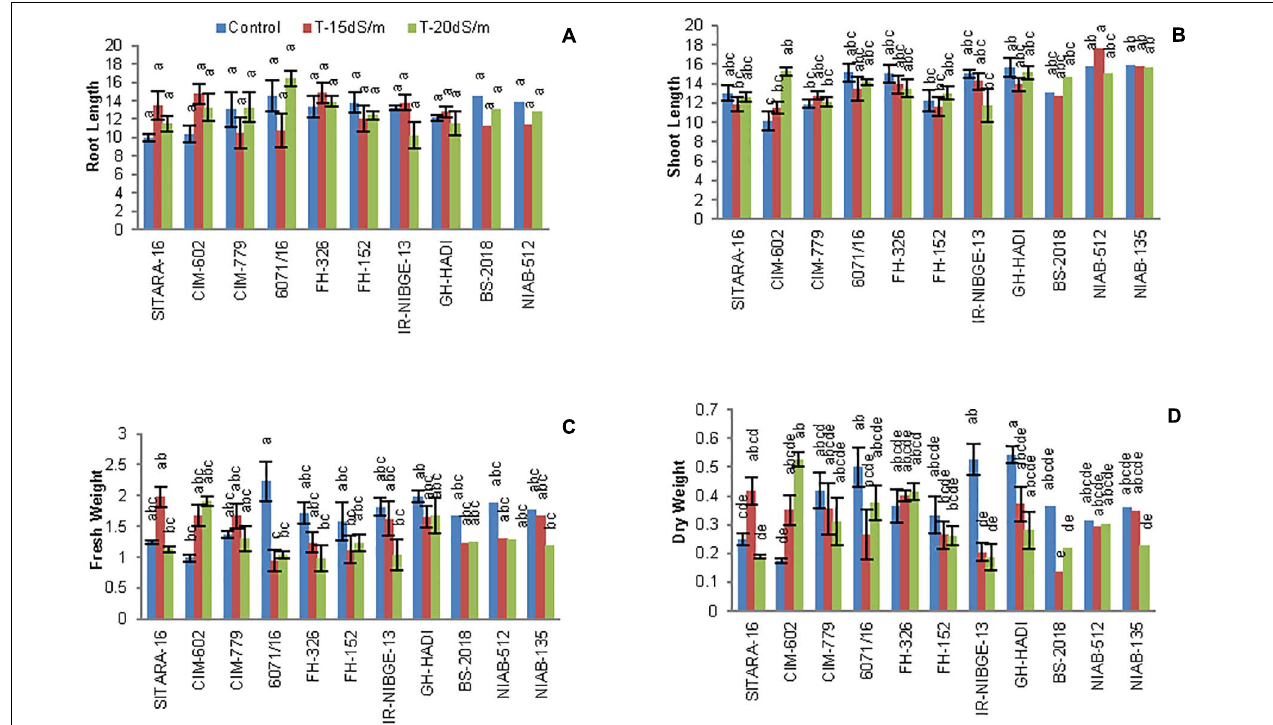
FIGURE 4 | Comparison of panels (A) root length, (B) shoot length, (C) fresh weight, and (D) dry weight between cotton genotypes under control and salt stress